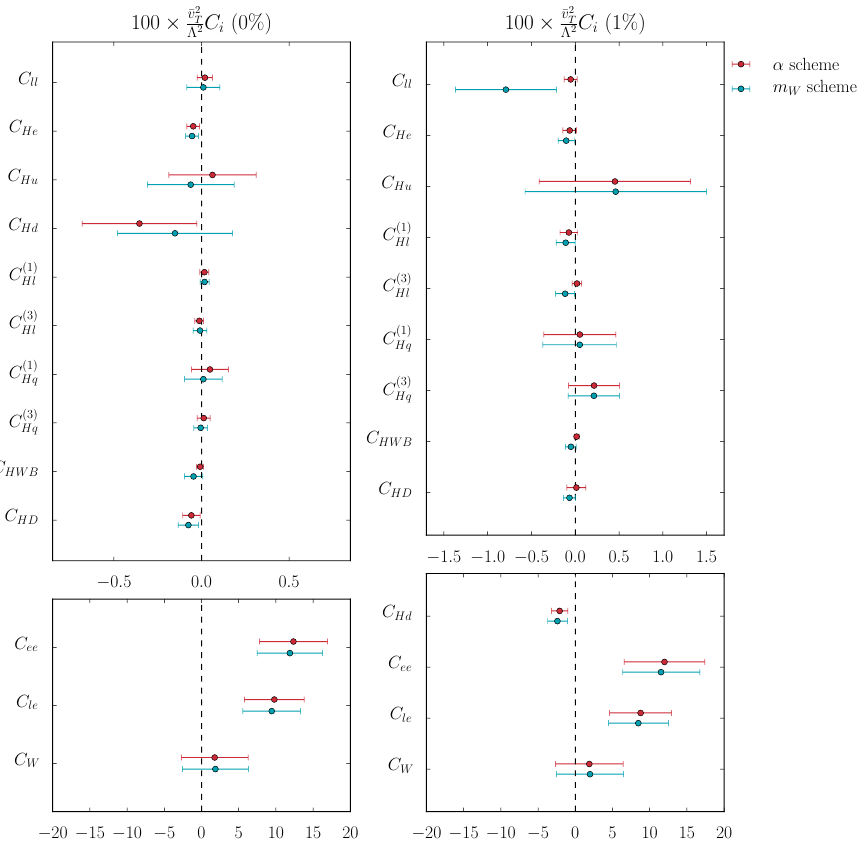
Figure 4 . Best (cid:12)t values of the Wilson coe(cid:14)cients (scaled by a factor 100) and corresponding 1 (cid:27) con(cid:12)dence regions obtained minimizing the (cid:1) (cid:31) 2 with one parameter at a time. Red (blue) (cid:6) points were obtained in the ^ (cid:11) ( ^ m W ) ; ^ m Z ; ^ G F input parameter scheme. The plot to the left f g has been obtained assuming (cid:1) SMEFT = 0, while the one to the right includes a theoretical error (cid:1) SMEFT = 0 : 01. Note that in the right plot the x axis has been scaled by a factor 2 and the coe(cid:14)cient C Hd has been moved to the lower panel: increasing the theoretical error enhances the 0 ;b pull of the anomaly compared to Z width data, and this relaxes by one order of magnitude FB A the bound on this